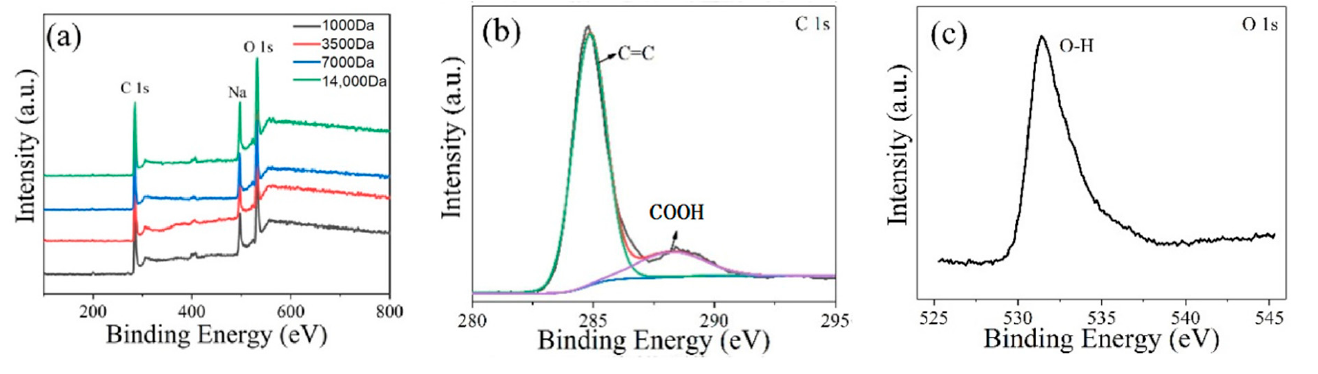
Figure 3. ( a ) XPS full spectra of four separated GQDs. High-resolution C 1s ( b ) and O 1s spectra ( c ) of GQDs dialyzed with